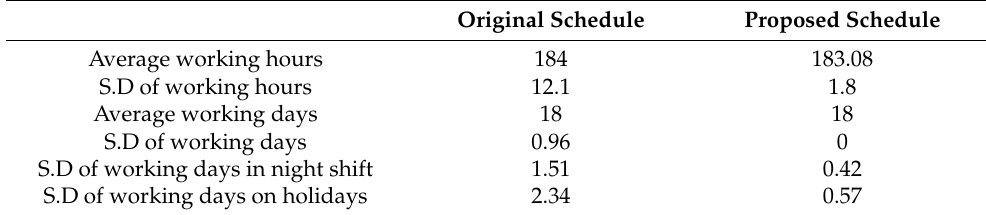
Table 4. Comparison between the original schedule and the proposed